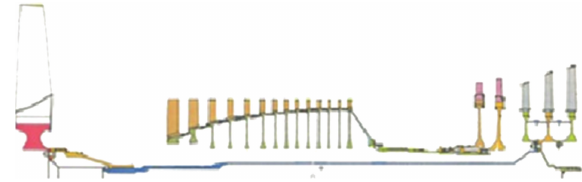
Figure 2: The model of a large alternator/flywheel train at the MIT Plasma Fusion